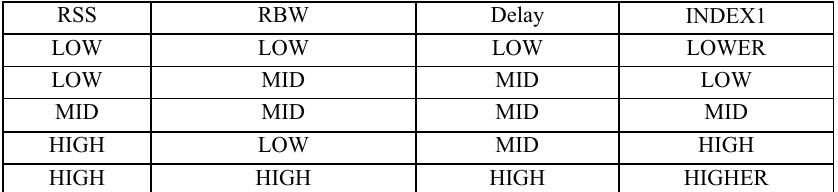
Table 4. Fuzzy rules for key